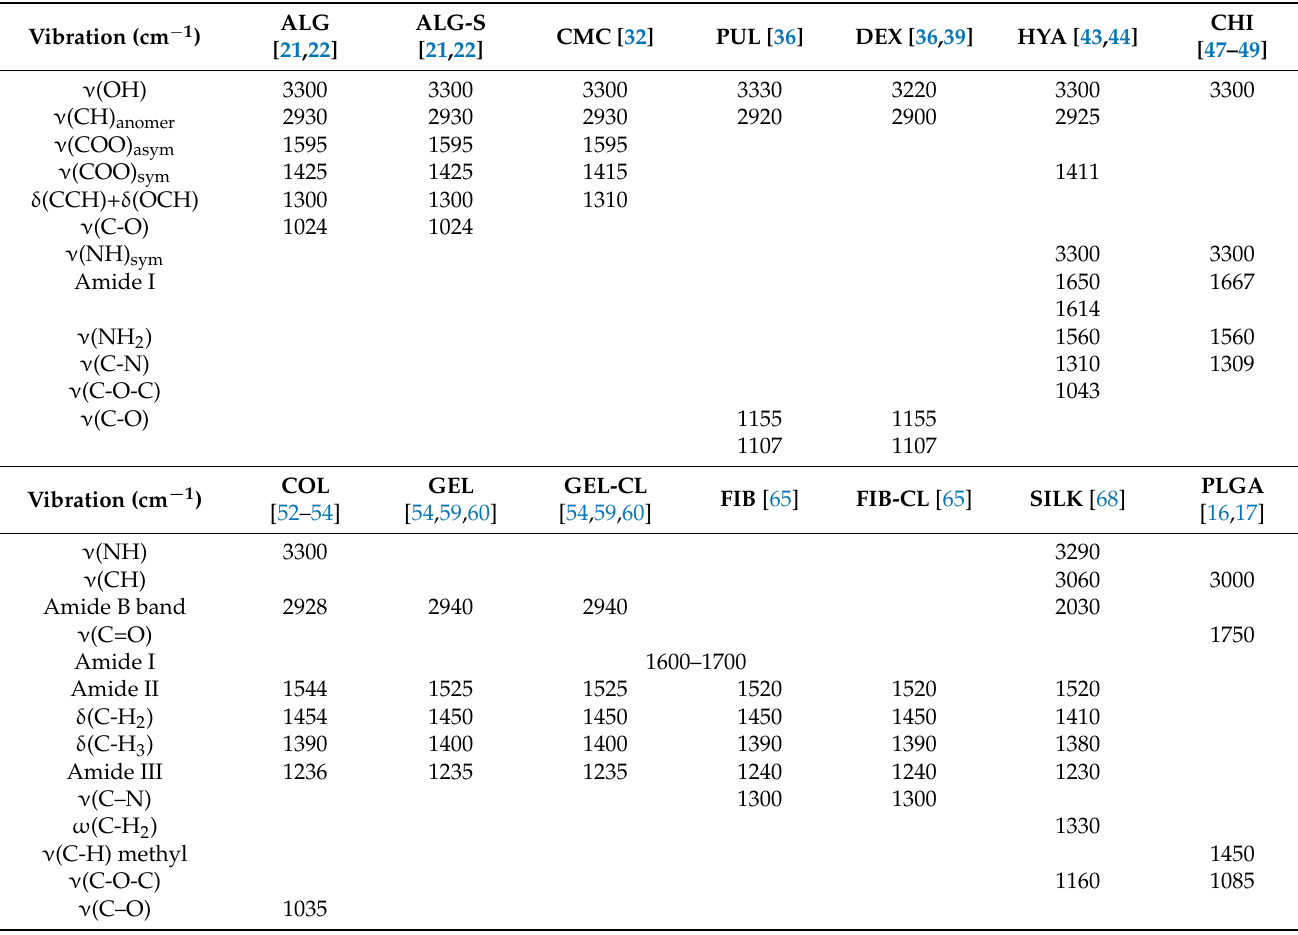
Figure 1. FTIR spectra of ALG, ALG-S, HYA, and COL thin films compared with the spectra of raw polymers and Si wafers. The characteristic bands are marked in grey, with the respective frequencies listed in Table 1 (spectra of the remaining polymers and thin films are available in the Supplementary Material, Figure S1). All carbohydrate samples show characteristic OH bands at about 3300 cm − 1 , with additional vibrations for CH and CO bonds. In addition, hyaluronic acid and chitosan show NH and CN vibrations, which are characteristic for amino groups. The protein samples show peaks for amide I, II, and III at polymer specific frequencies and additional vibrations for CH and CO groups. PLGA has a strong and narrow peak at 1750 cm − 1 , characteristic for its ketone groups, and additional peaks for CH and C-O groups. Table 1. Characteristic vibration frequencies of polymer thin films measured using ATR-FTIR and compared to data from previous